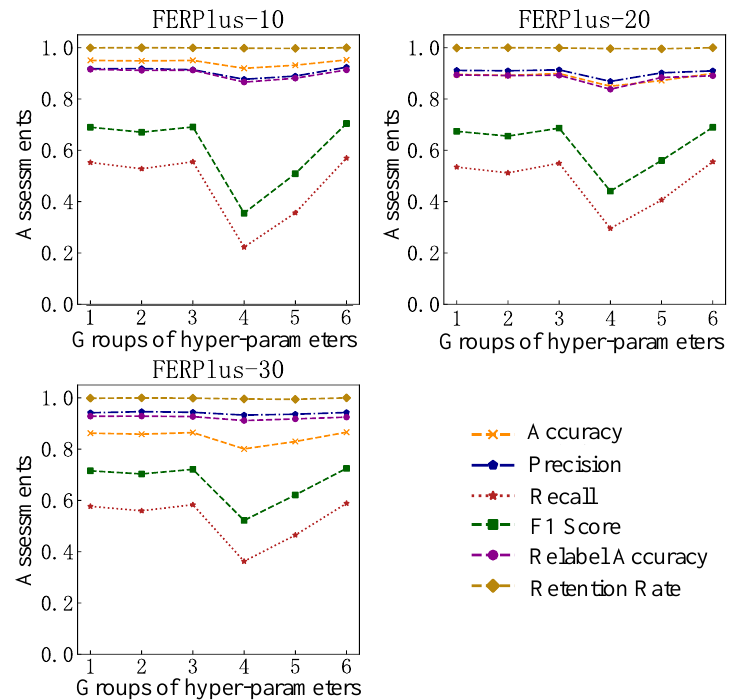
Figure 6. Dynamic noise detection effect of different noise proportions.